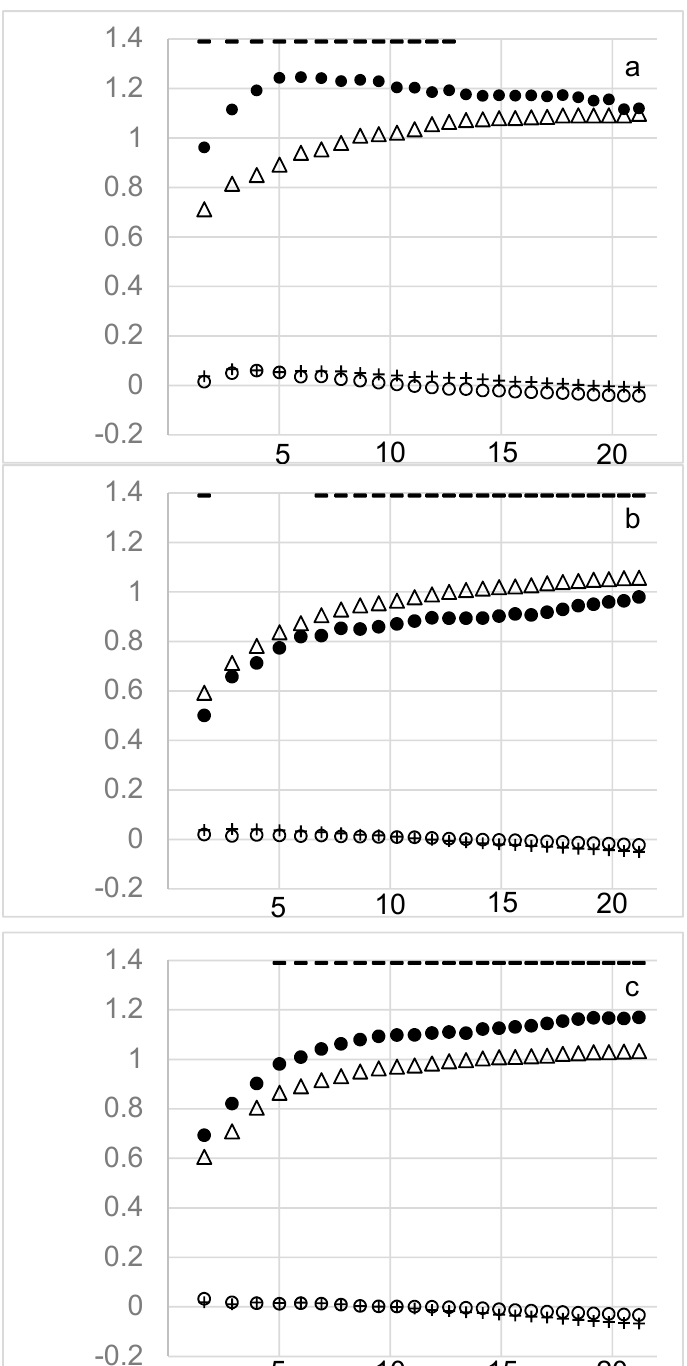
Figure 3. Haplotype capture at three sets of target genes using genomewide single nucleotide polymorphism (SNP), geographic, and environmental data to assemble subsets in sorghum. Target gene sets are a ) lignin biosynthetic genes, b ) regulatory genes, c ) climate adaptation genes. Plotted points are coded by reference data source: triangles, whole genome; closed circle, target genes; plus sign, geography; open circle, environment. X-axis, average physical length of haplotype blocks (Kbp). Y-axis, rescaled relative enrichment of haplotypic diversity at target gene sets, zero is random expectation. Dashes at top indicate significant difference between whole genome (triangle) vs. target gene (closed circle) reference (Holm-Bonferroni corrected p -value < 0.05).